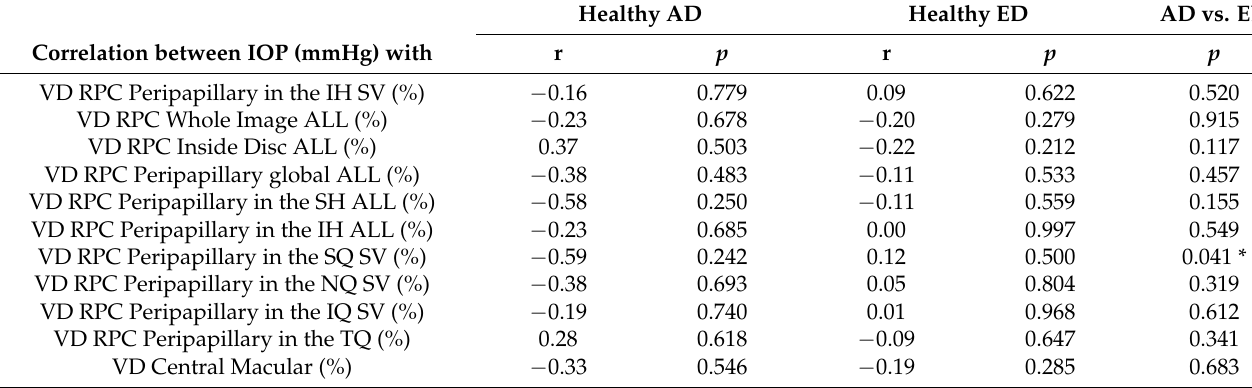
Table 5. Cont. Healthy AD Healthy ED AD vs.